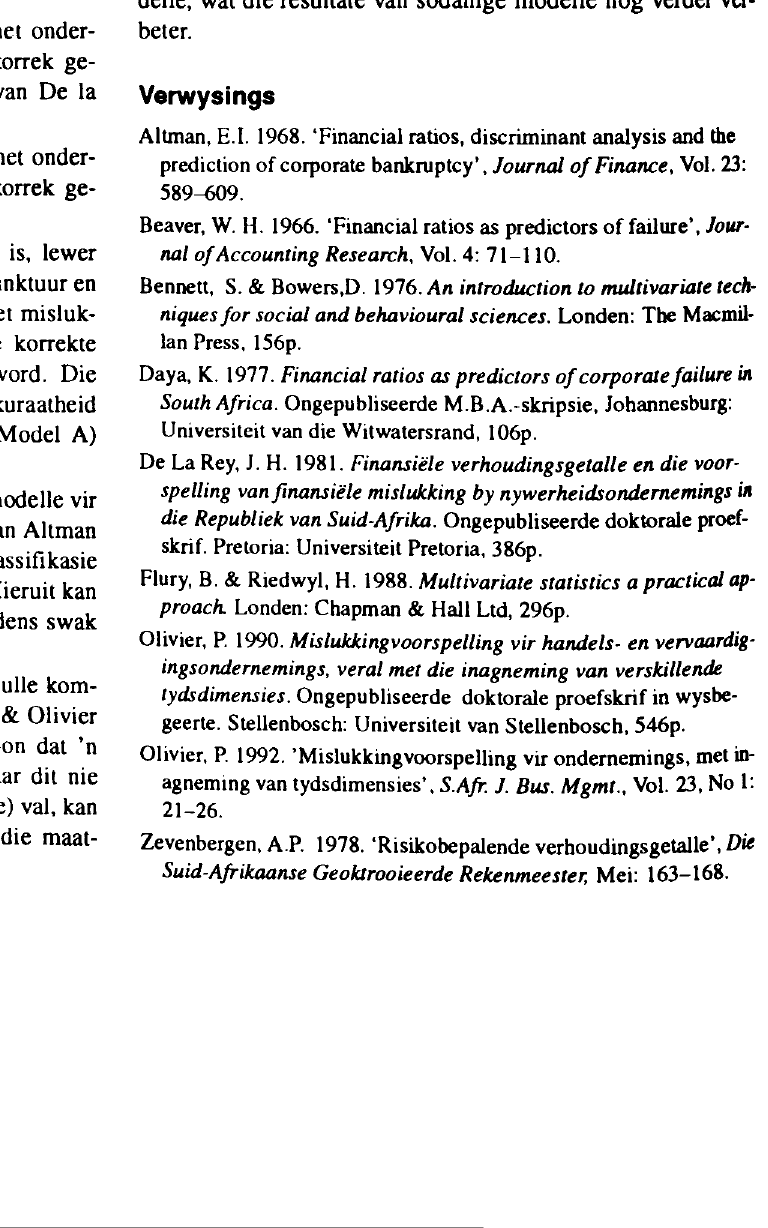
Tabel 11 Persentasie maatskappye deur